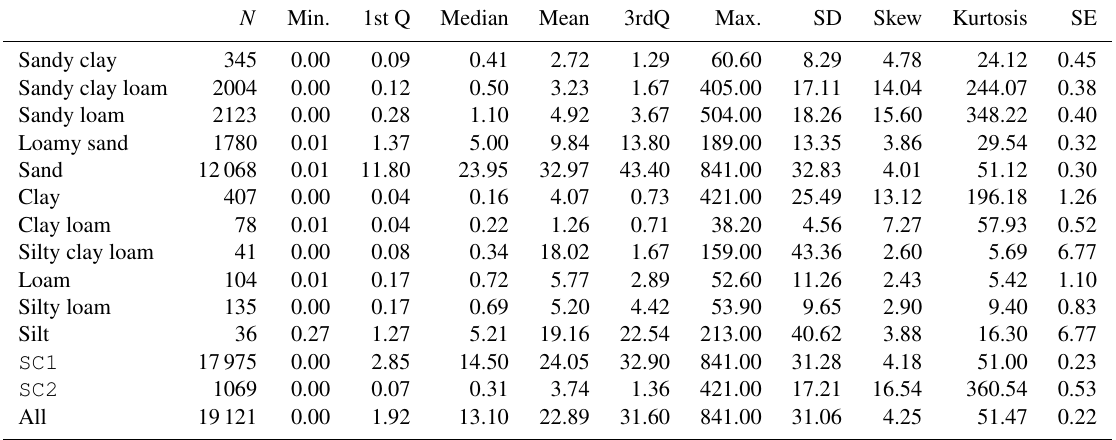
Table 1. Statistical description of K sat (cmh − 1 ) values by classes. Soils have also been grouped into two super classes, SC1 and SC2 , which can be interpreted as the sandy class and not sandy class, respectively. Legend: N , the number of soils in each class; SD, the standard deviation; skew, the skewness number; SE, the standard error; and 1st Q, the first quartile. N Min.